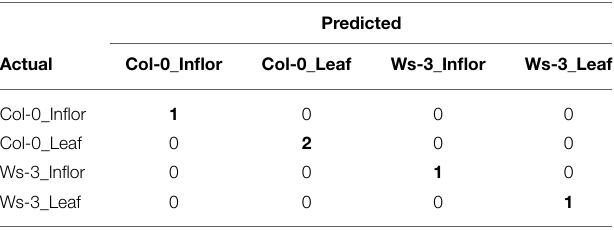
Inflor: Inflorescence. The bold values indicate that the actual identities of the samples are equal to the